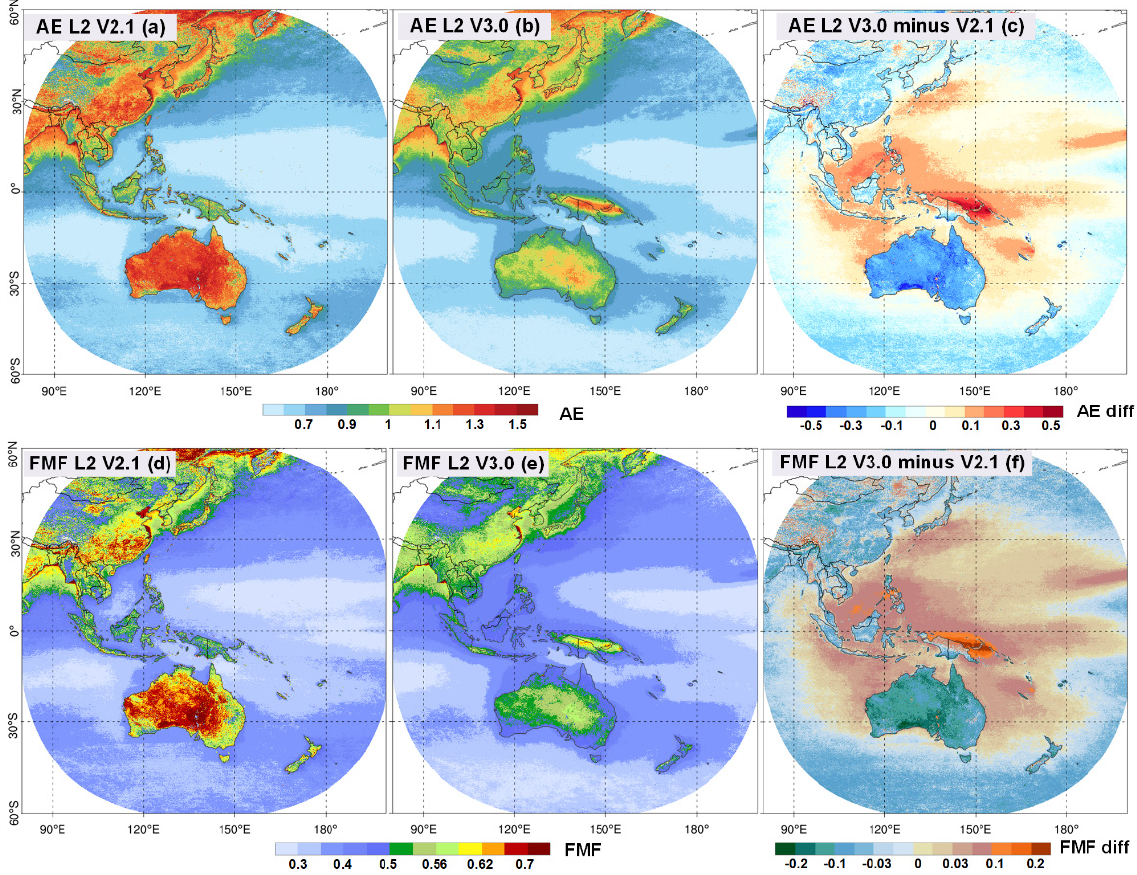
Figure 6. Spatial distribution of the averaged Himwari-8 L2 V2.1 AE ( a )/FMF ( d ), the averaged Himwari-8 L2 V3.0 AE ( b )/FMF ( e ), difference of the averaged V3.0 and V2.1 AE ( c )/FMF ( f ) (V3.0 minus V2.1) in 2020.